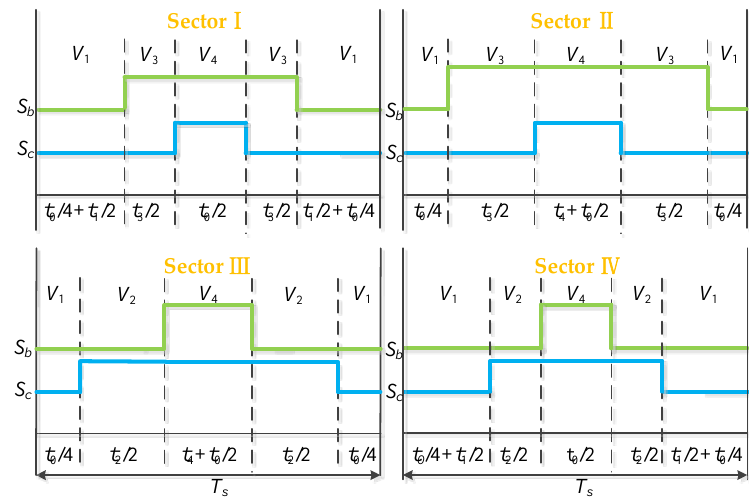
Figure 3. Model predictive control (MPC) principle.